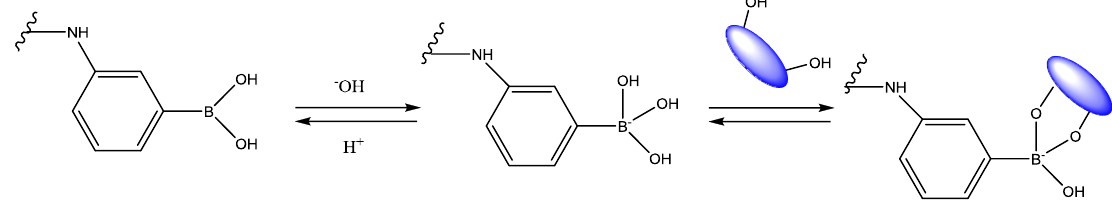
Figure 2. Simplified 3-aminophenylboronic acid (APBA) equilibrium in the presence of glucose. ARS has been used as a reagent for the fluorimetric determination of boronic acid concentrations.